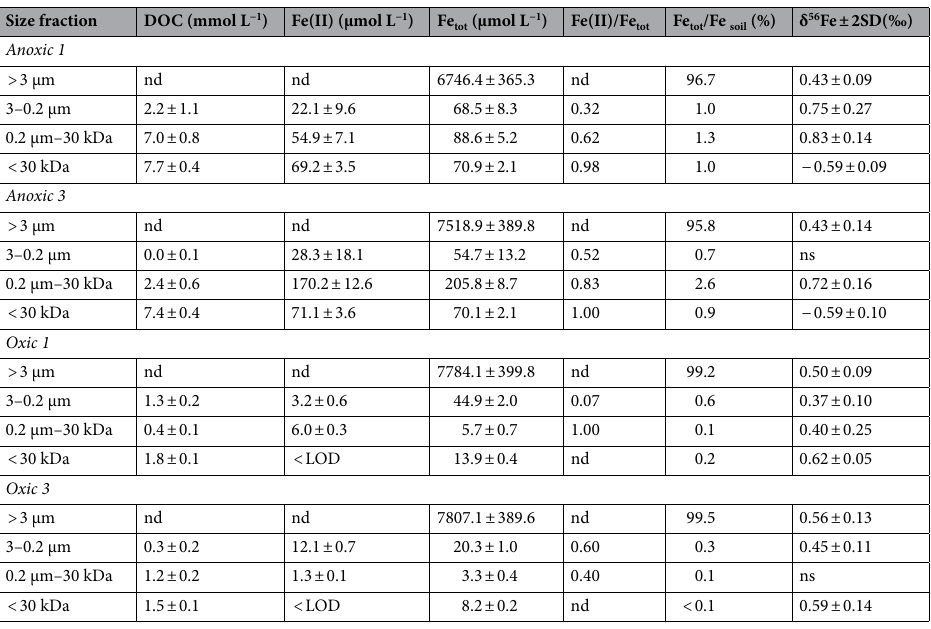
Table 1. Chemical and isotopic compositions of the filtrated and ultrafiltrated samples for anoxic and oxic periods 1 and 3. DOC dissolved organic carbon, ns not significant, nd not determined, < LOD below the limit of